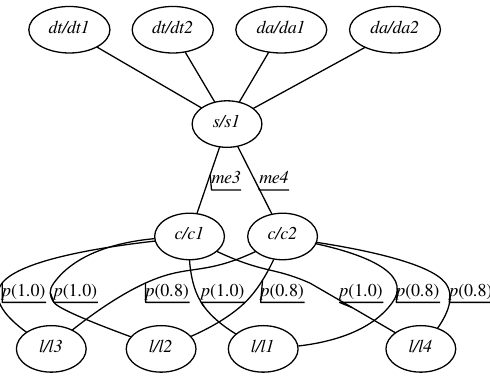
Figure 4. A street segment, logical model: a Control Availability Graph; no logical relationships among detectors.